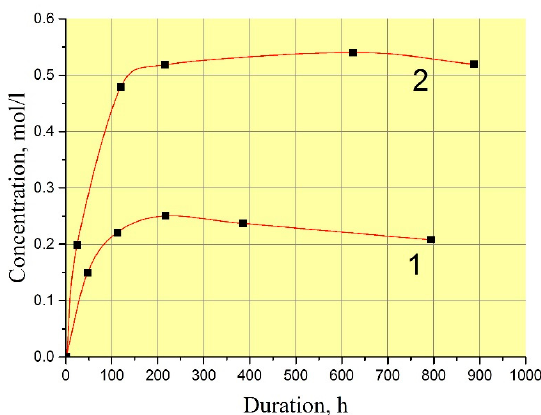
Figure 3. Kinetics of GaPO 4 dissolution in 9 M H 3 PO 4 /6 M HCl (vol. proportion 95/5%) at 240 °C and 10–15 bar. 1—with crystallization; 2—without crystallization.